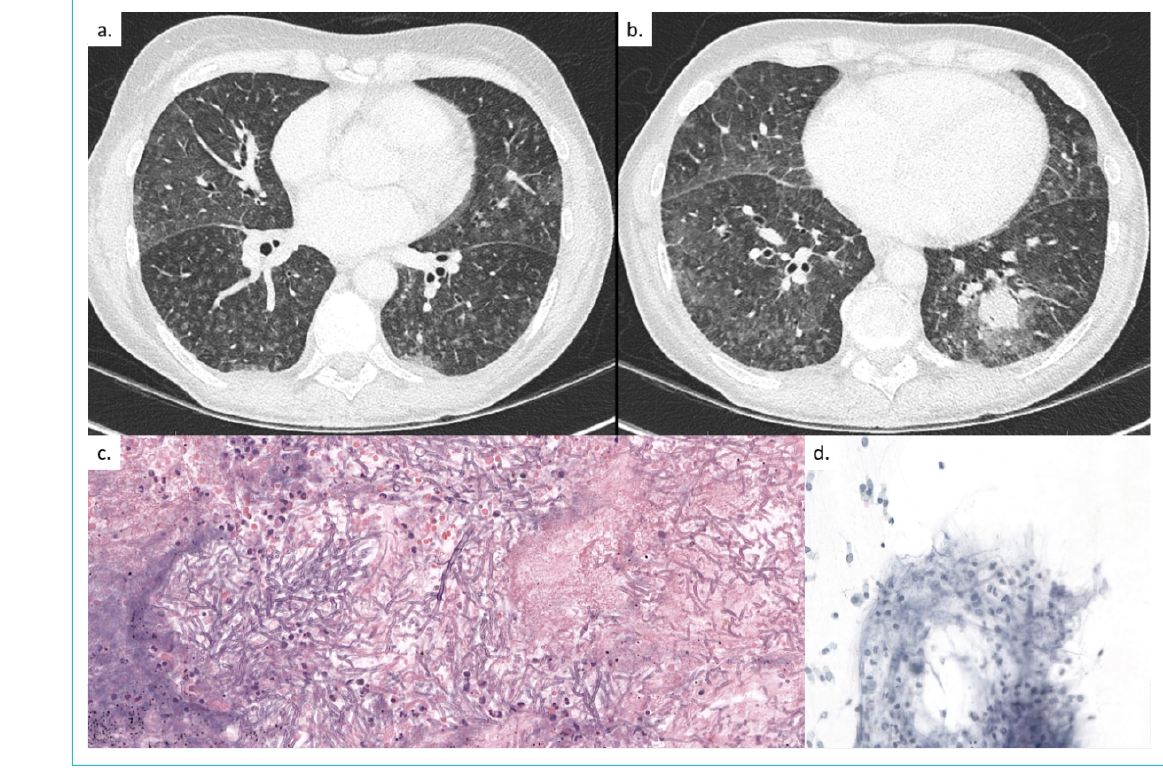
Figure 1: (a) Pulmonary computed tomography (CT) on day 12 showing diffuse ground-glass opacities with numerous micro-nodules, primari- ly in the superior lobes and the apical segments of the inferior lobes. (b) Pulmonary CT on day 23 showing progression of the diffuse bronchi- olitis signs and a new nodular lesion of 2 cm in the left lower lobe with a halo sign. (c) Transbronchial biopsy on day 42 showing multiple, nar- row, septated, branching hyphal forms on haematoxylin and eosin stain identified by PCR as Aureobasidium spp.. Abundant presence of lymphocytes, neutrophils, fibrocytes, bronchial cells and alveolar macrophages indicating an inflammatory process. (d) Part of the trans- bronchial biopsy on Grocott stain showing the fungal hyphal forms identified by PCR as Aureobasidium